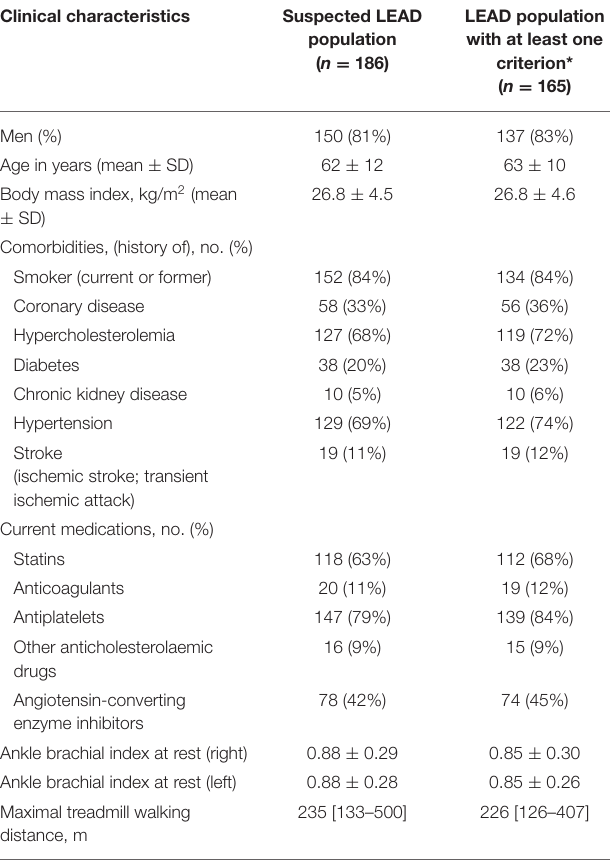
TABLE 1 | Population